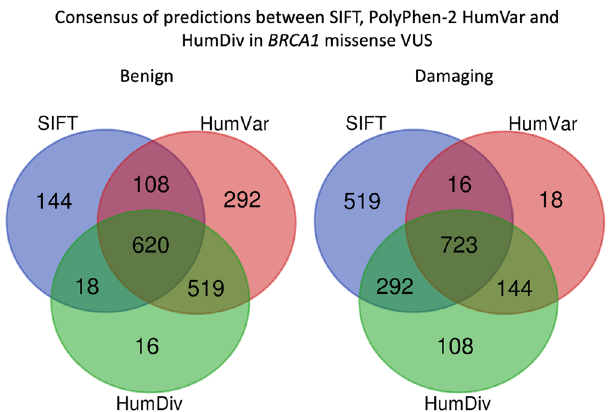
Figure 5. Summary of consensus in prediction outcomes for BRCA1 missense VUS.